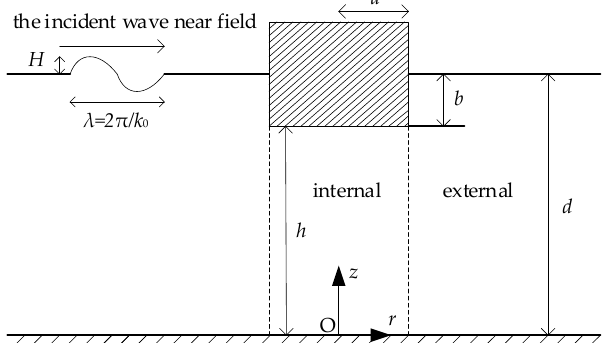
Figure 2. Simplified diagram of the float in wave.